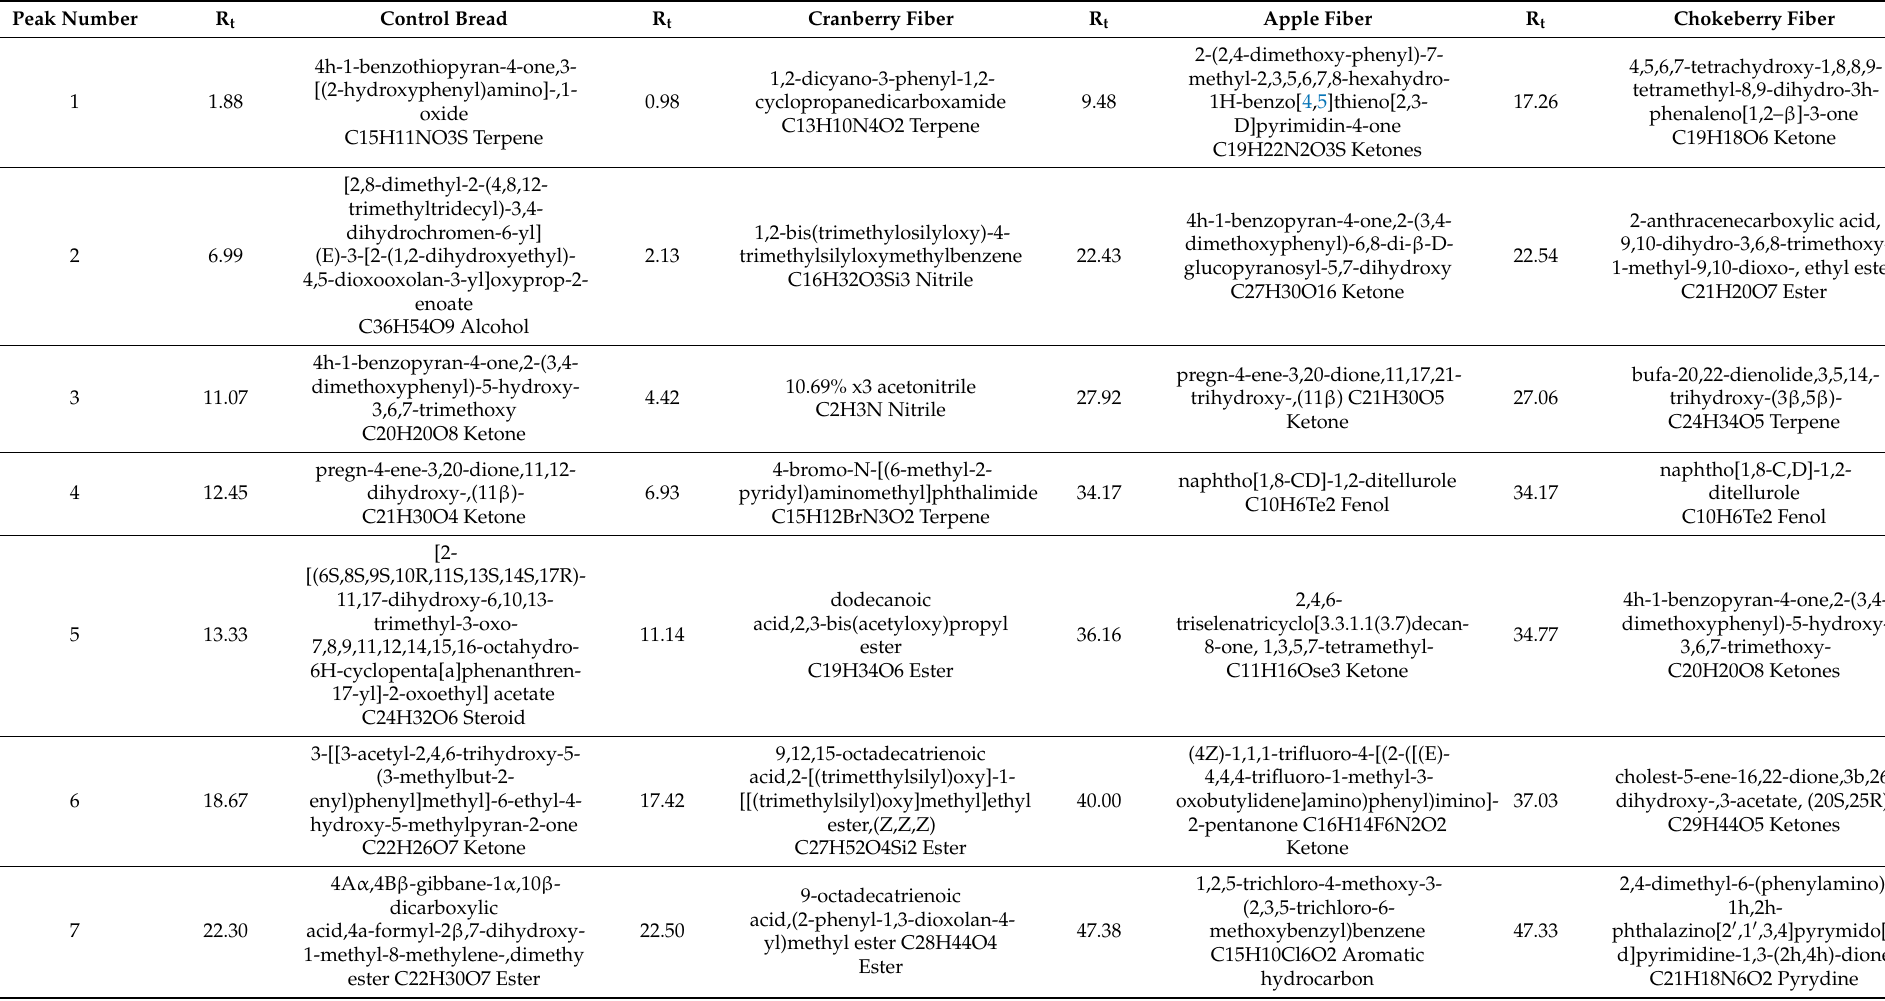
Table 3. Main VOCs identified in the bread odorant SPME